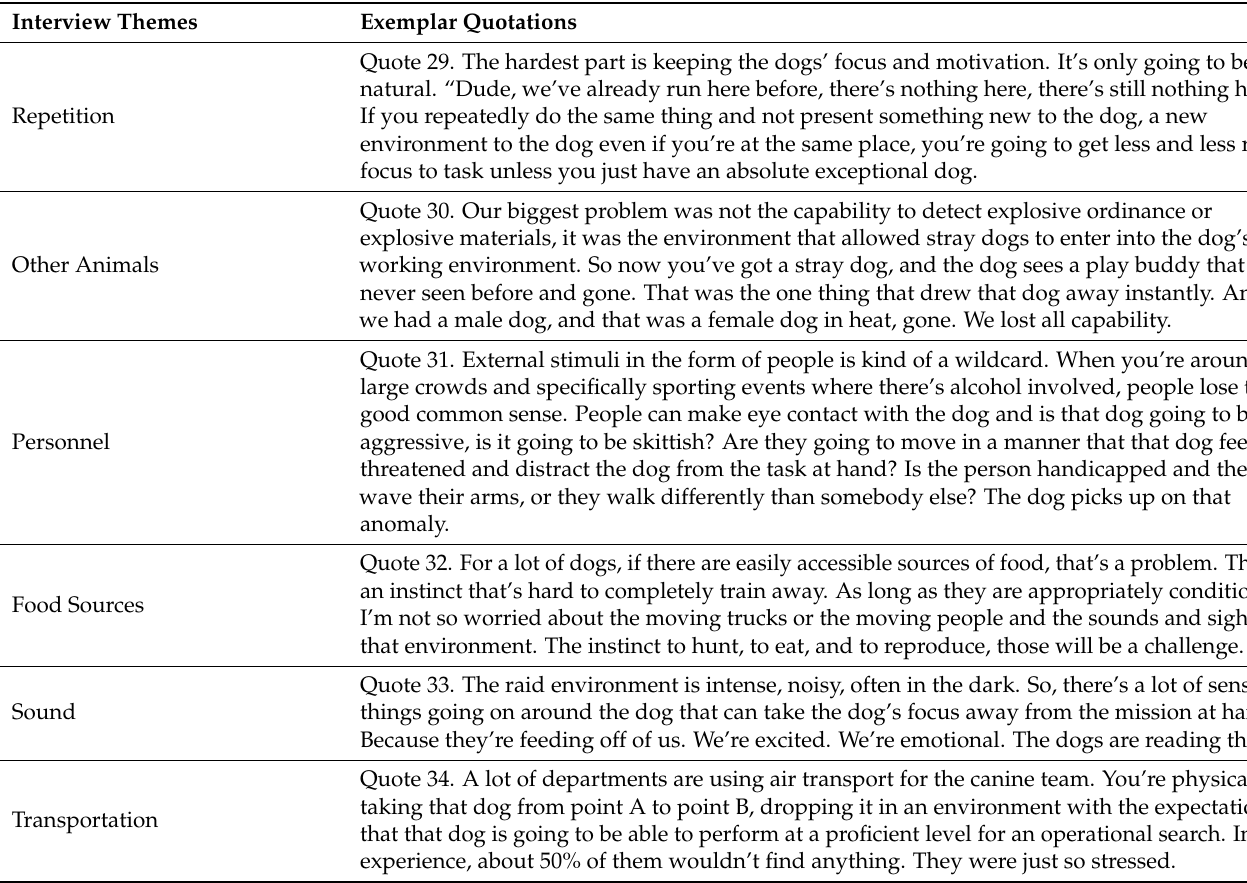
Table 7. Operational environmental factor themes and exemplar